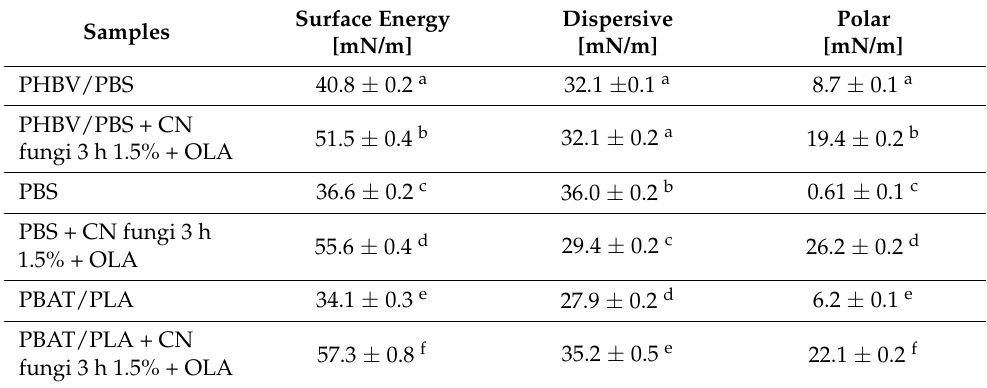
Table 9. Surface energy of substrates uncoated and coated with chitin + OLA. For each column of results, the same letter means that values were not significantly different (confidence level